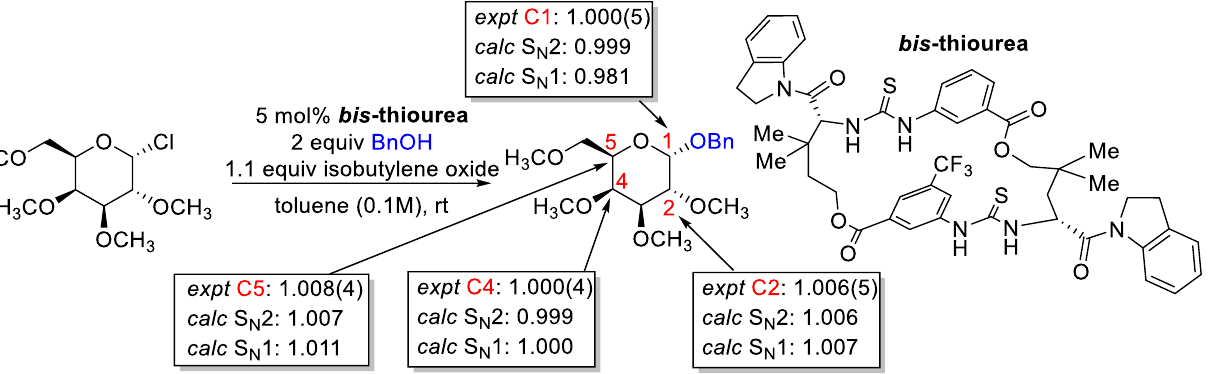
Figure 20. bis -Thiourea catalyzed glycosylation. All values are obtained from the work of Kwan, Jacobsen, and co-workers [179] . “ Expt ” refers to experimental 13 C KIE relative to the C2 methoxyl group. “ Calc S N 2 ” refers to the calculated KIE value at PCM/PBE0-D3(BJ)/6-31G(d) and the Biegeleisen– Mayer method [181] adjusted with the Bell infinite parabola tunneling correction. “ Calc S N 1” refers to the equilibrium isotope effect.